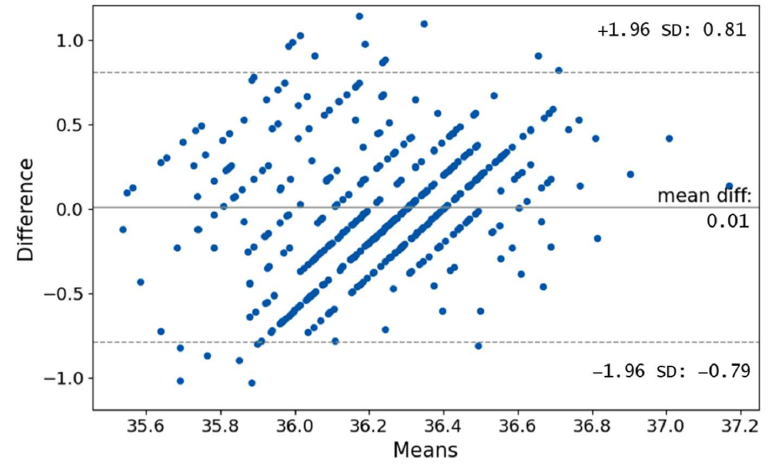
Figure 10. Relationship between the IRT eyes maximum temperature and APT temperature.